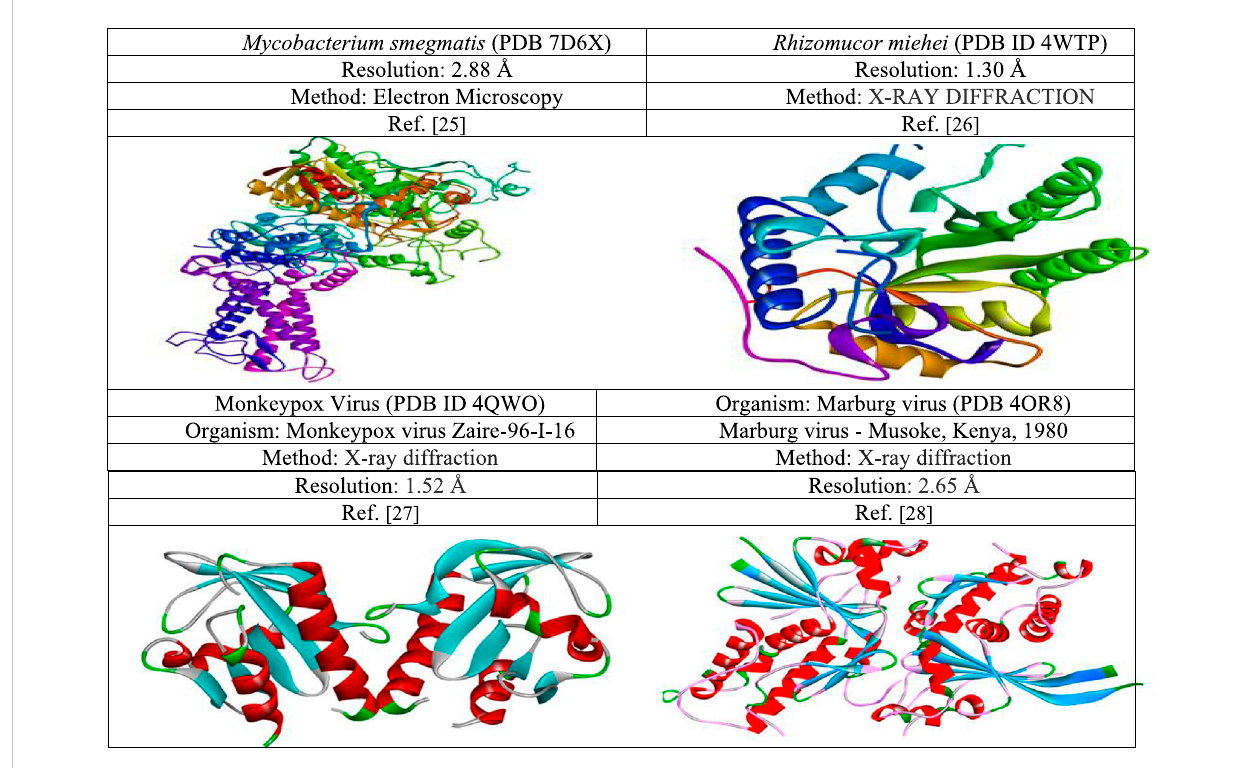
FIGURE 3 Three-dimensional protein structure of black fungal, Monkeypox, and Marburg virus target proteins used in this